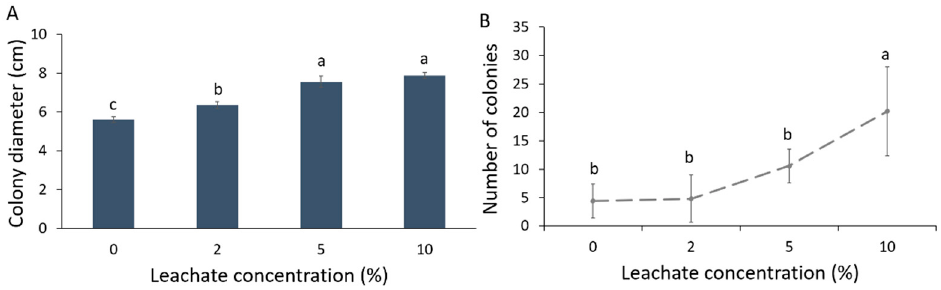
Figure 1. Growth and sporulation of Fusarium oxysporum f. sp. radicis-lycopersici (Forl) at 0, 2, 5, and 10% biosolid leachate concentrations in PDA. ( A ) Mean colony diameter; ( B ) Mean sporulation. Different letters indicate statistically significant differences between the treatments according to Tukey’s post hoc test ( p < 0.05).